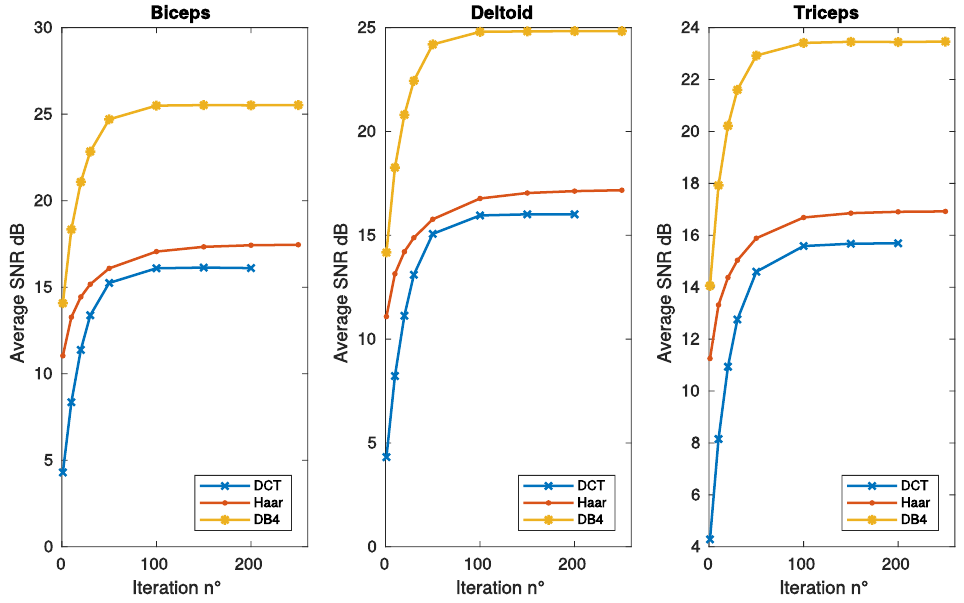
Figure 3. SNR vs. algorithm iterations, as achieved with convex optimization, for the same bases and muscles of Figure